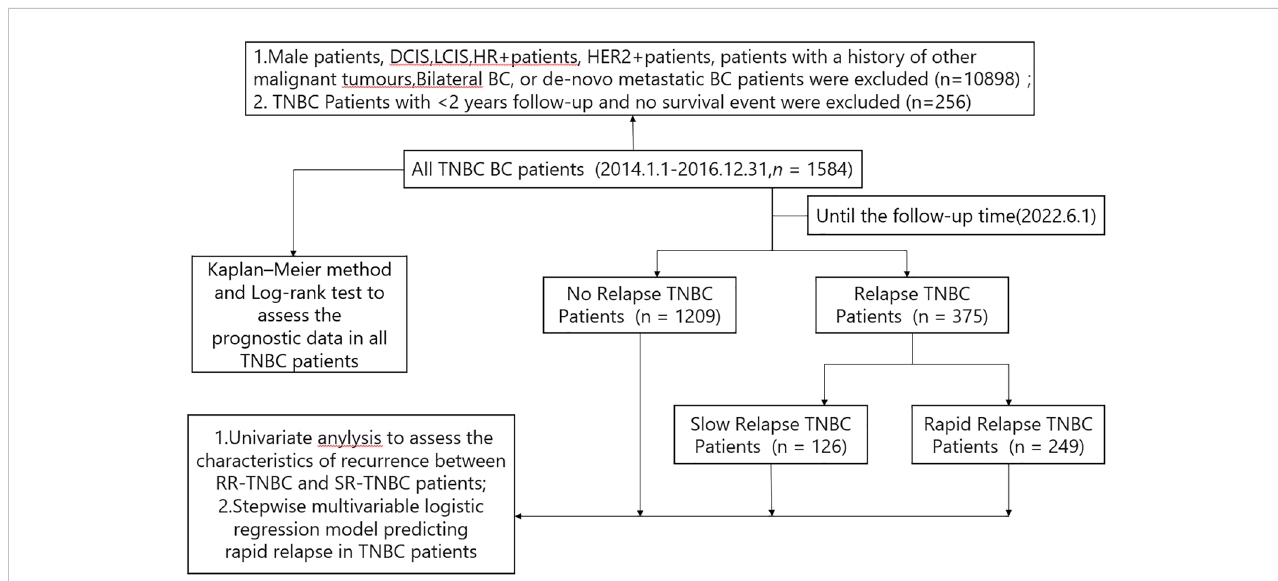
FIGURE 1 Constitution of the study population.BC, breast cancer; HR+,hormone receptor positive; HER2+, human epidermal growth factor receptor 2 positive; TNBC,triple negative breast cancer; RR-TNBC:rapid relapse-triple negative breast cancer; SR-TNBC:slow relapse-triple negative breast cancer; DCIS, ductal carcinoma in situ; LCIS, lobular carcinoma in